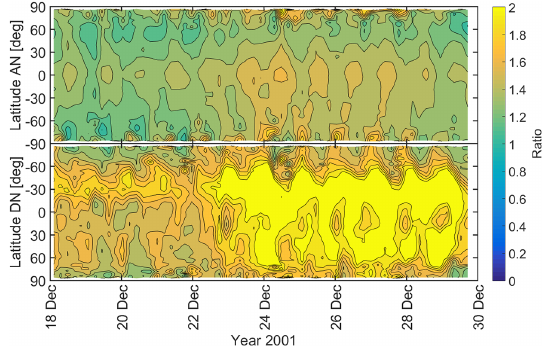
Figure 10. Density ratio (GITM / CHAMP) as a function of time and latitude for “case a” (local time of ascending node, LTAN = 15:10; local time of the descending node, LTDN = 03:10; h apogee = 469km; h perigee = 405km).